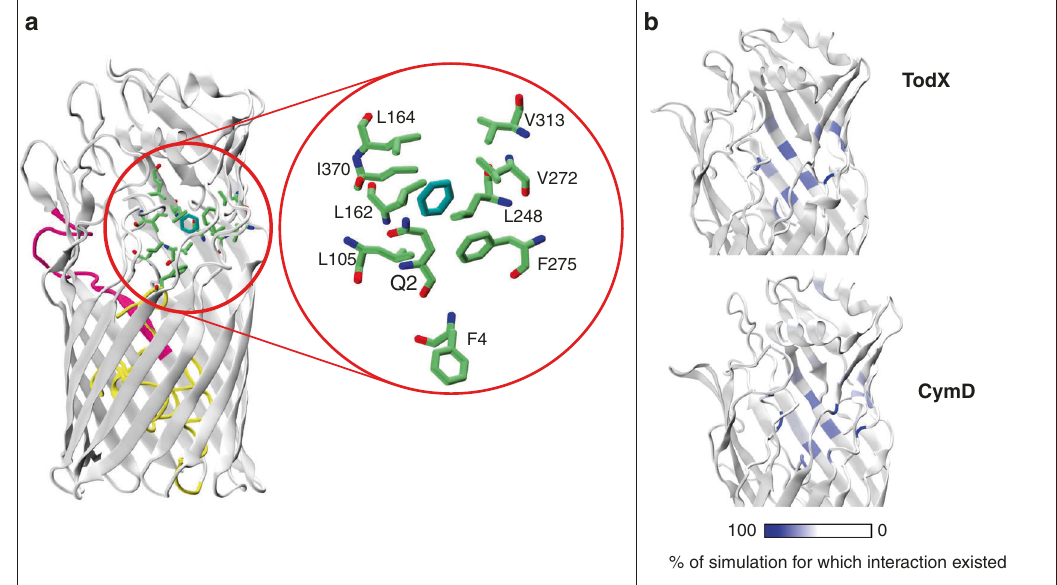
Fig. 3 MD simulations reveal binding pockets for MAH in TodX and CymD. a Cartoon model showing state II TodX residues mediating the largest number of interactions with benzene (blue) from equilibrium MD simulations as green stick models. These residues form the P-pocket. b Comparison of the location of residues in TodX and CymD that form the largest number of interactions with benzene and p-cymene respectively. Residues are coloured by the percentage of simulation time for which the interactions occur, with data included for both independent simulations of each protein. Interactions are de fi ned as an inter-atomic distance of <4.0 Å.